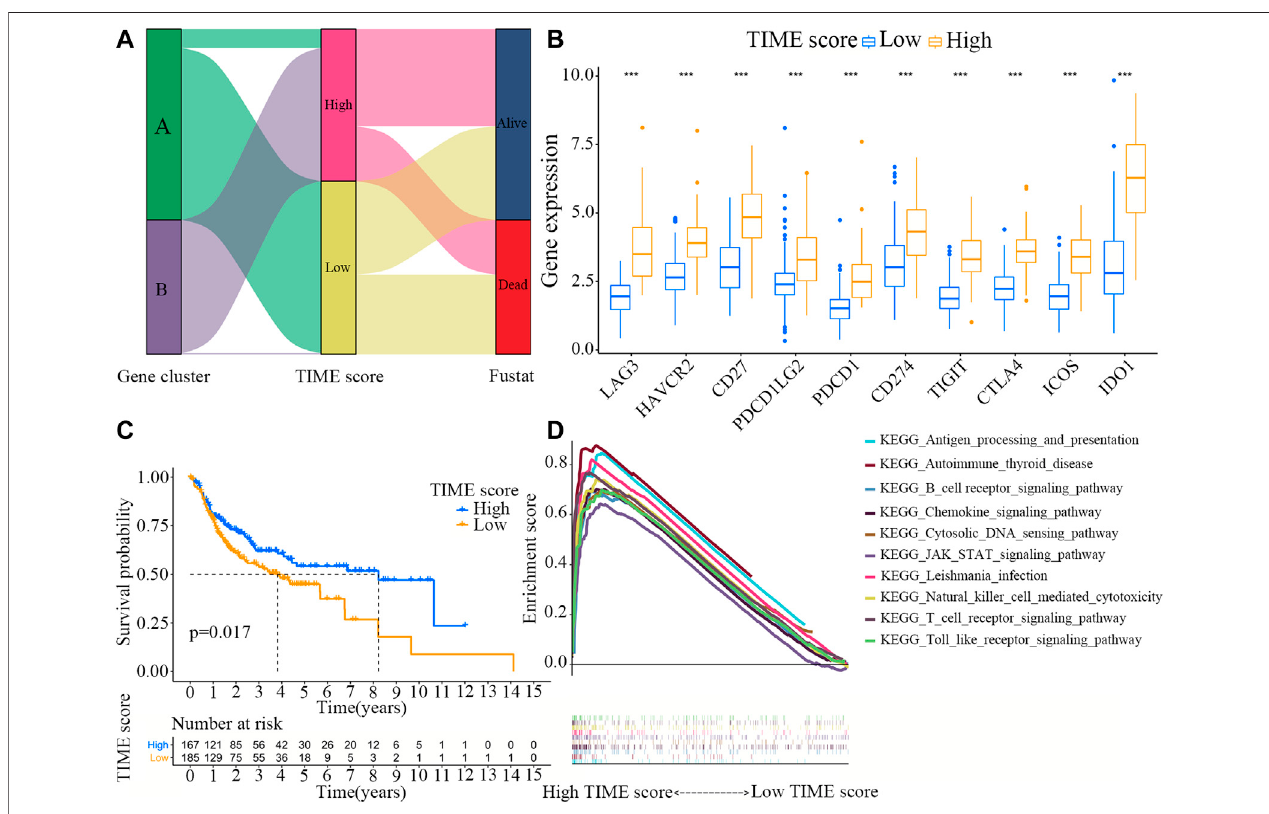
FIGURE3| Construction and analysisofthe TIMEscoregroups. (A) Distribution patterns of OSCC patients inthe twoTIME geneclusters. (B) Expression levels of the immune checkpoint-related genes (LAG3, HAVCR2, CD27, PDCD1LG2, PDCD1, CD274, TIGIT, CTLA4, ICOS and IDO1) in high and low TIME score groups. (C) Survival rates of OSCC patients in high and low TIME score groups. Log-rank test, p = 0.017. (D) GSEA analyses of the genes in high TIME score